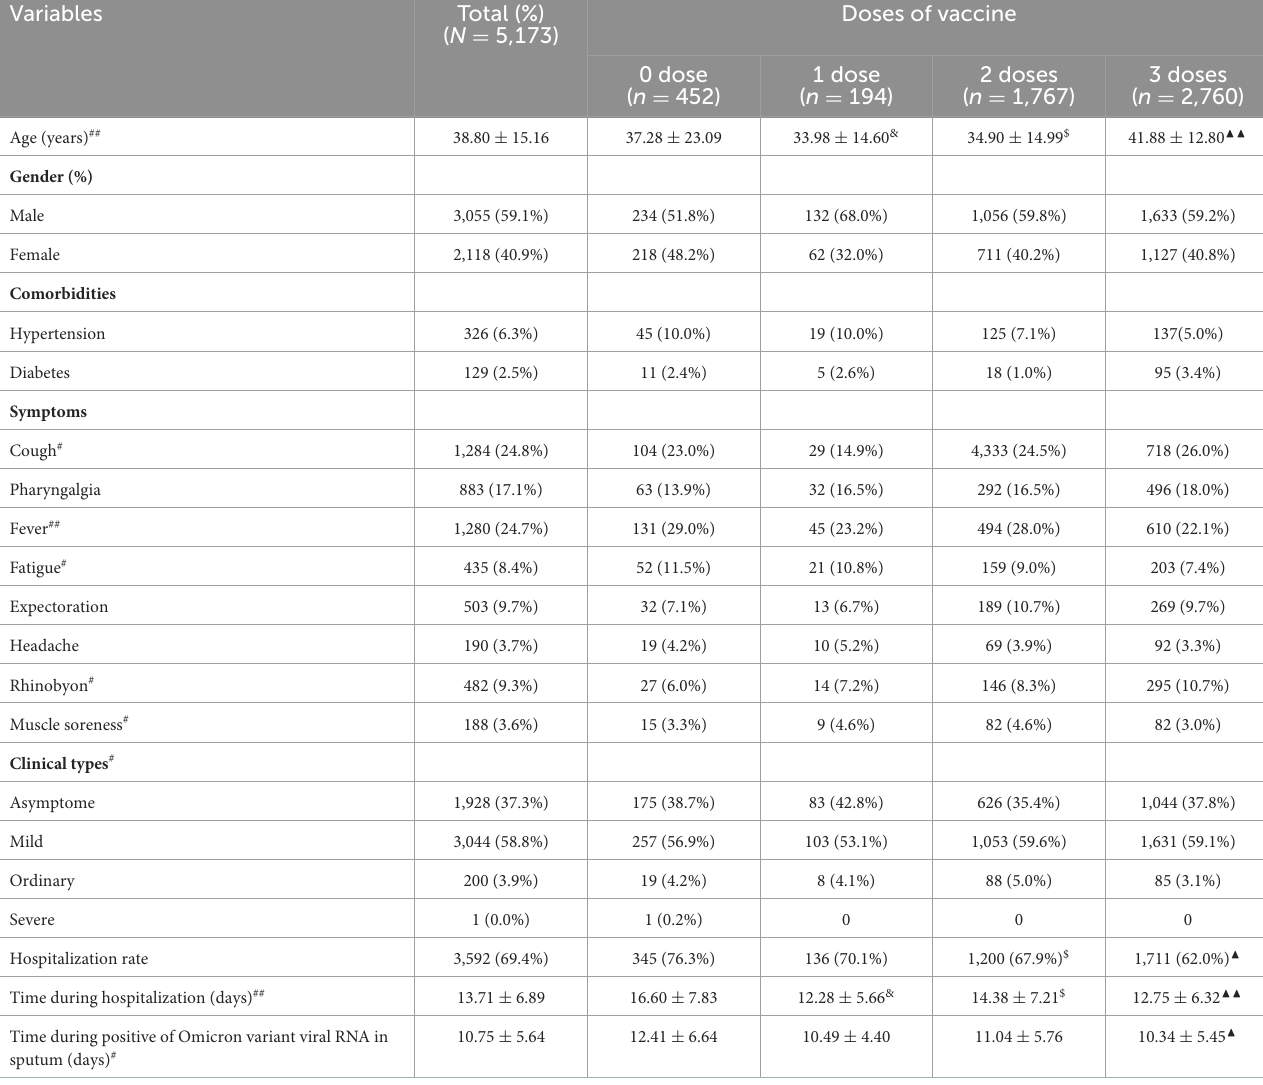
TABLE 1 Demographic, history, clinical symptoms, and clinical types of different doses of vaccine for COVID-19 infected with Omicron variant. Variables Total (%)